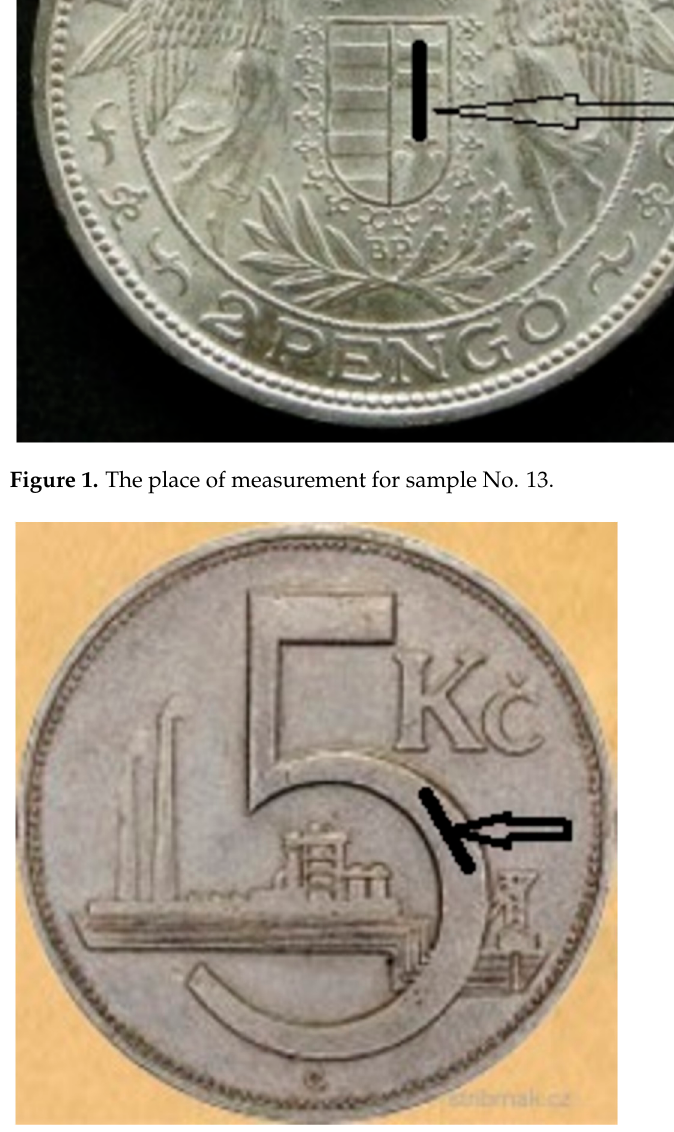
Figure 2. Place of measurement for sample No. 16.